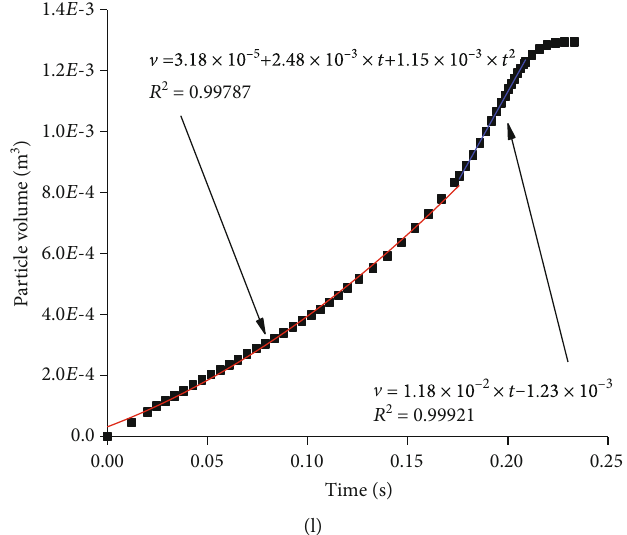
Figure 12: Simulated fi tting curves for particle size is 100 × 100 × 300 mm (a) P = 0 : 5 MPa , (b) P = 0 : 8MPa , (c) P = 1 : 0MPa , and (d) P = 1 : 2MPa ; and particle size is 100 × 100 × 250 mm (e) P = 0 : 5MPa , (f) P = 0 : 8MPa , (g) P = 1 : 0MPa , and (h) P = 1 : 2MPa ; and particle size is 100 × 100 × 200mm (i) P = 0 : 5 MPa , (j) P = 0 : 8MPa , (k) P = 1 : 0 MPa , and (l) P = 1 : 2 MPa .